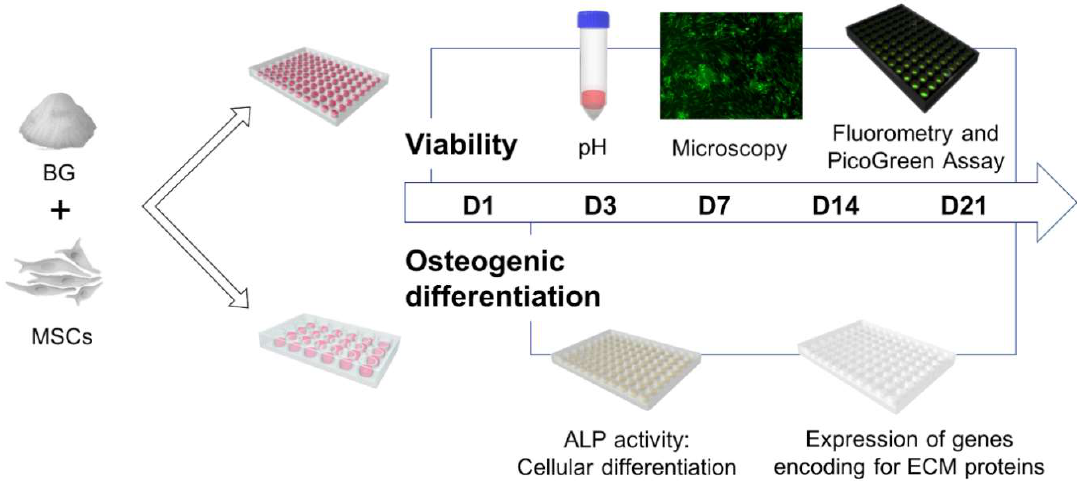
Figure 5. Overview of the experimental design. Mesenchymal stromal cells (MSCs) were co-cultured in direct contact to BG and CBG, respectively. On day (D)1, D3, D7, D14, and D21, viability was evaluated qualitatively and quantitatively via fluorescence microscopy and fluorometry. The content of double-stranded DNA (dsDNA) was assessed by PicoGreen assay and pH values were measured. On D3, D7, D14, and D21, ALP activity and expression of genes encoding for ECM proteins were analysed.